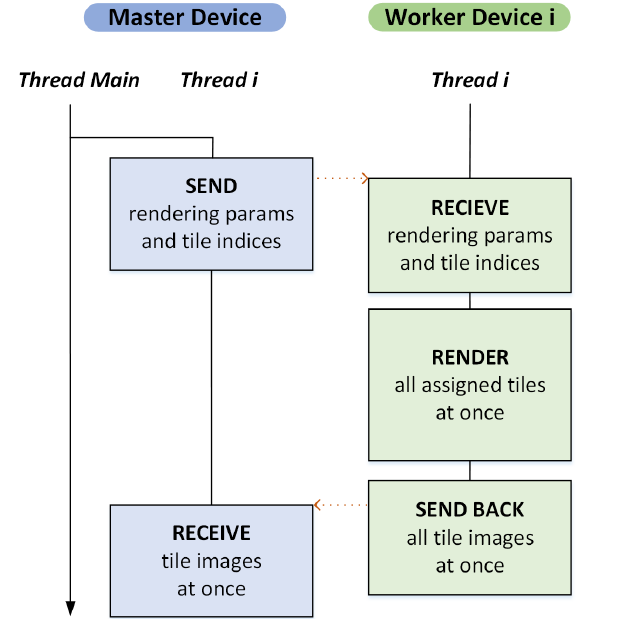
Figure 5. Master–worker interaction model II. As more workers participate, the increased communi- cation between mobile devices becomes the dominating factor that harms the efficiency of distributed rendering. To overcome the problem, we propose adopting a simpler approach using static load balancing. Interestingly, the uneven load distribution across workers paradoxically improves the efficiency by effectively overlapping the tasks of image transmission and GPU ray